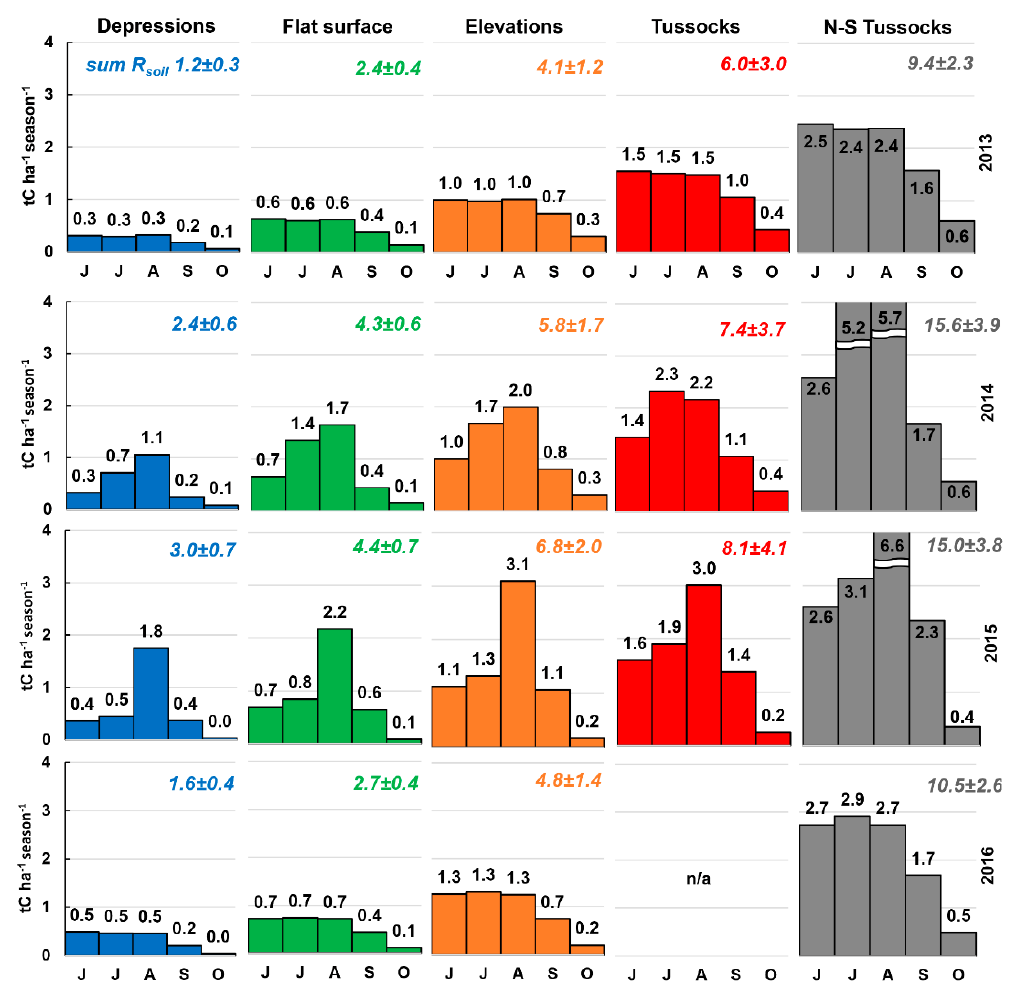
Figure 7. Simulation of seasonal R soil fluxes. The upper right part shows the total for the season (June–October) R soil ± σ in tC ha −1 (the sum of σ of the parameters of the model).